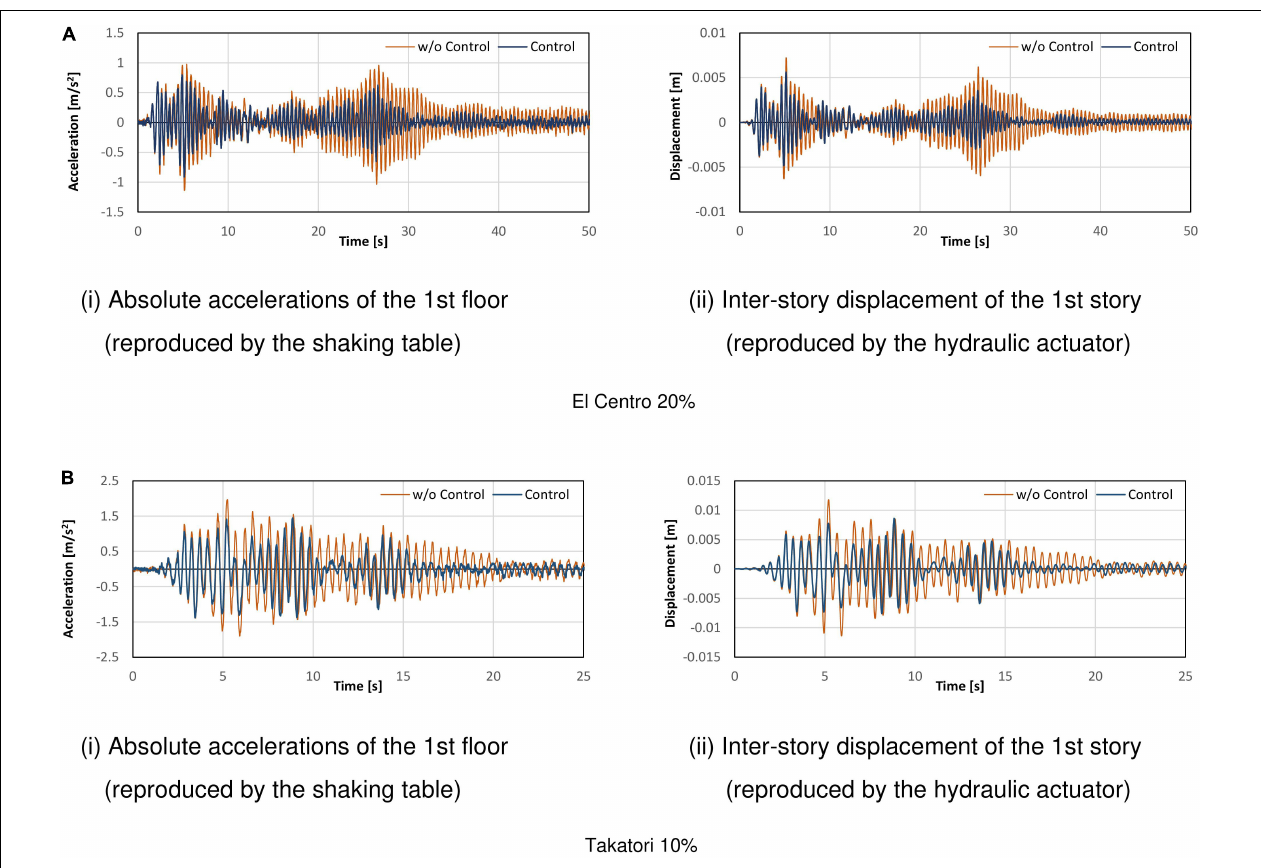
FIGURE 10 | Comparison of responses between with/without control in the RTHS test. (A) El Centro 20%, (i) Absolute accelerations of the 1st floor (reproduced by the shaking table) and (ii) Inter-story displacement of the 1st story (reproduced by the hydraulic actuator). (B) Takatori 10%, (i) Absolute accelerations of the 1st floor (reproduced by the shaking table) and (ii) Inter-story displacement of the 1st story (reproduced by the hydraulic actuator).